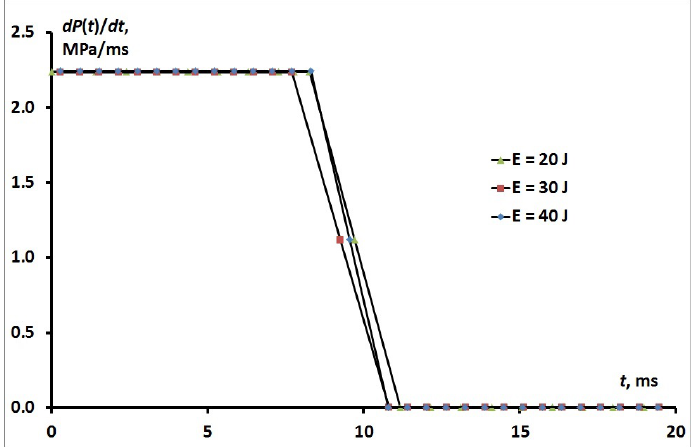
Figure 4. Transition of the ˙ P from elastic compression of suspension to